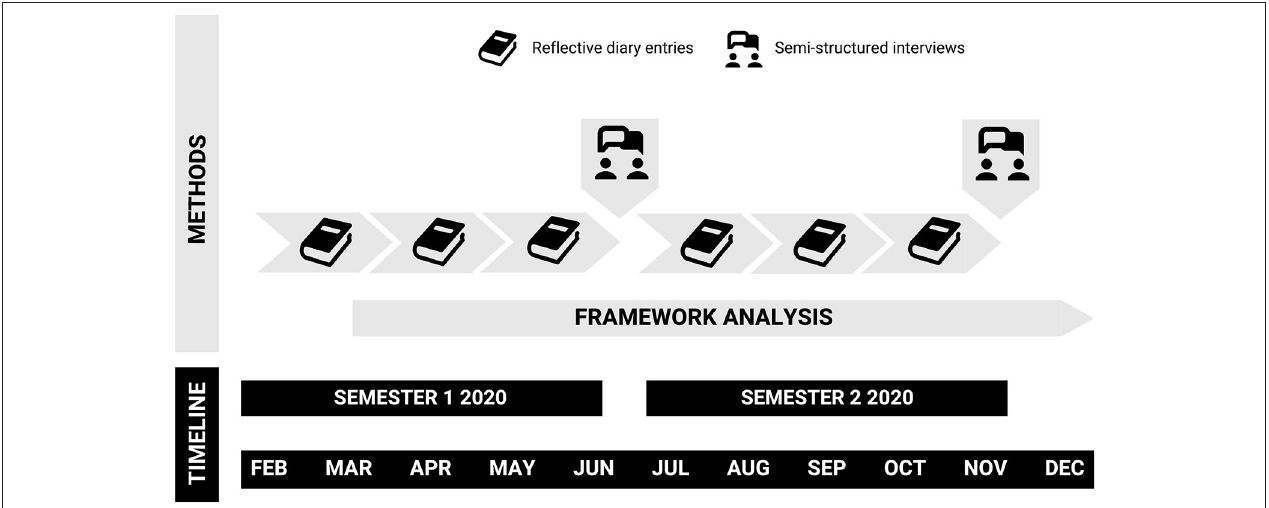
FIGURE 1 | Overview of study methods and timeline. Participants described their experiences of uncertainty through in-semester reflective diary entries, and discussed their experiences through end of semester individual or group semi-structured interviews. Framework analysis of data began following the collection of the